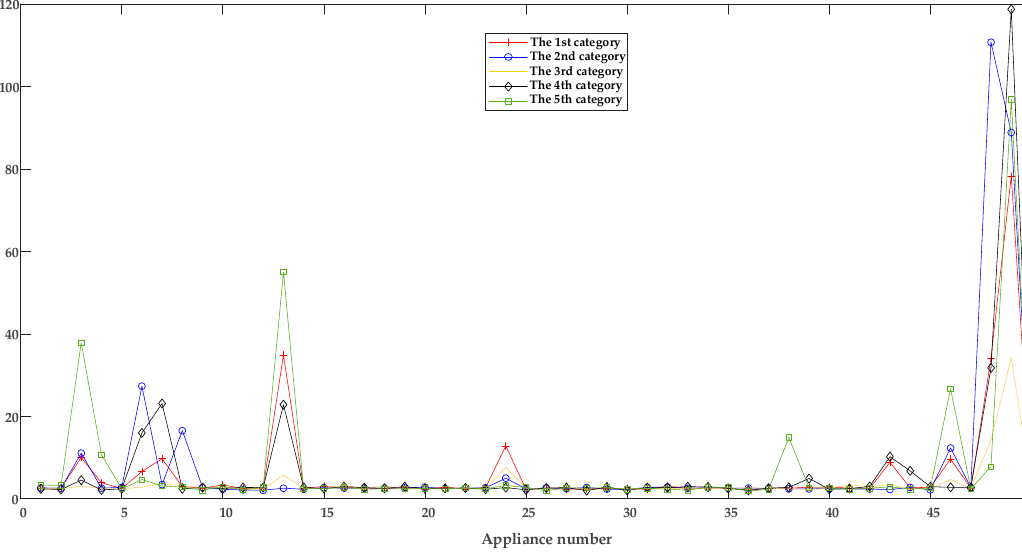
Figure 9. Five types of users’ electrical energy consumption clustering center curve.